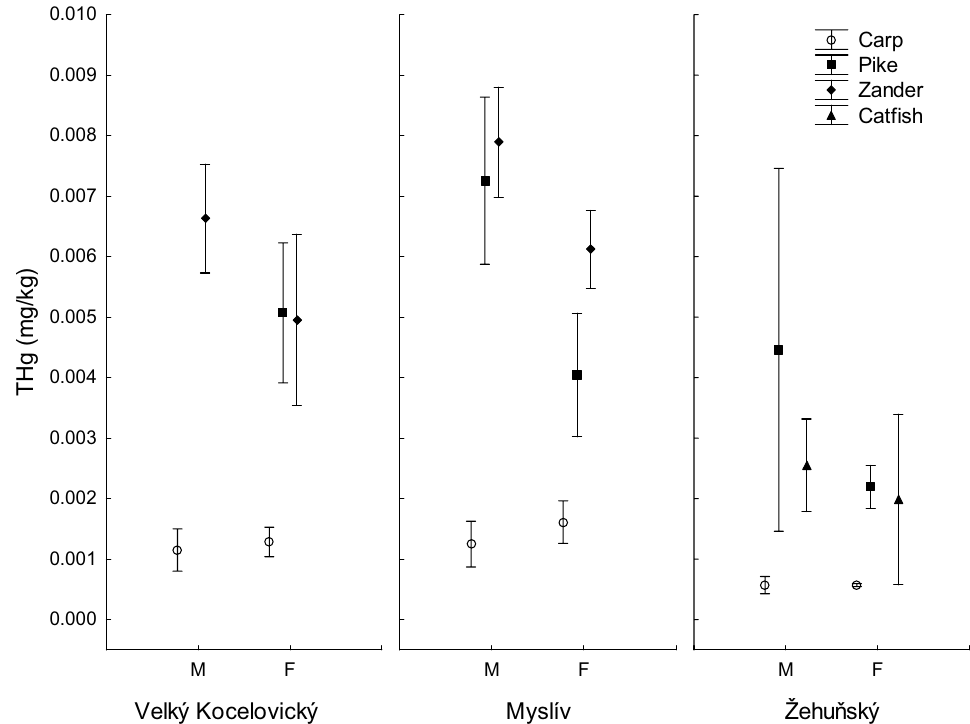
Figure 3. Total mercury content (mg/kg wet weight) in gonads of male (M) and female (F) carp, pike, zander and catfich caught in three sampling sites. Vertical bars denote 0.95 confidence intervals.